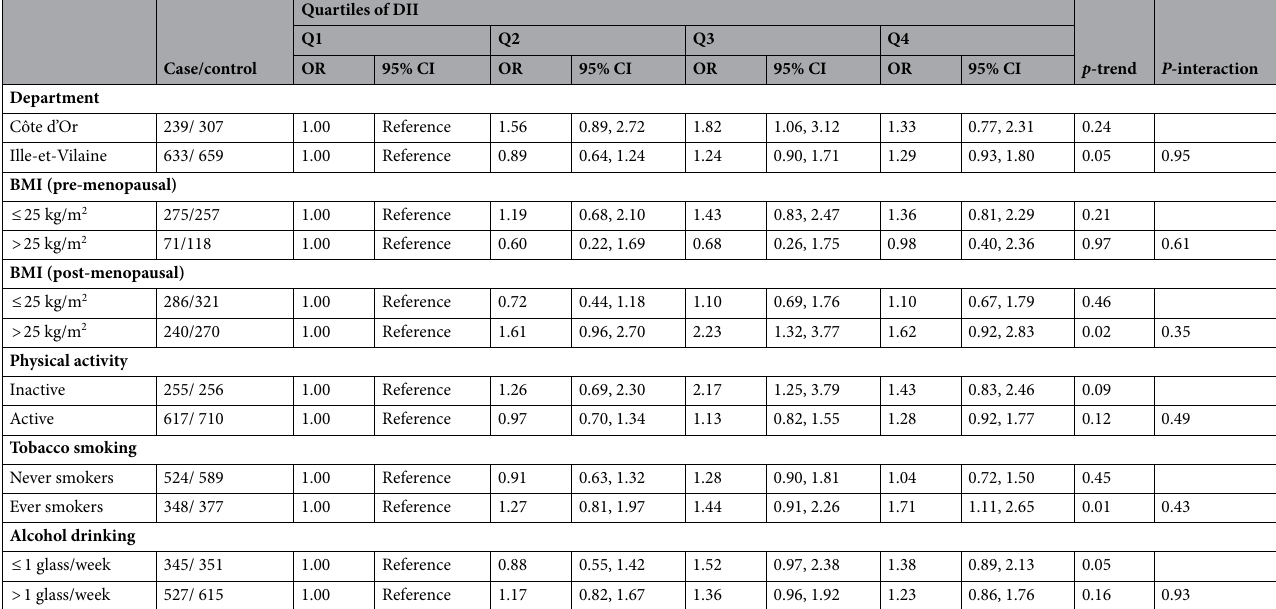
Table 4. Odds Ratios (ORs) and 95% Confidence Intervals (CIs) for breast cancer associated with the Dietary Inflammatory Index (DII). Stratification by selected breast cancer risk factors. The CECILE study, France, 2005–2007. P trend determined from the model using the median value in each quartile as a quantitative variable. Odds ratios adjusted for study area, age at reference date, history of benign breast, family history of breast cancer in first-degree relatives, age at menarche, parity, age at first full-term pregnancy, breast feeding, menopausal status, current use of hormone therapy, oral contraceptive use and body mass index. No adjustment on the stratification variable.